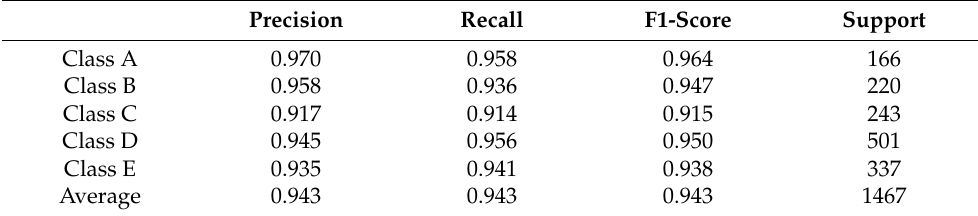
Table 2. The results of an 18-layer Residual Network (ResNet18) with the three-dimensional feature.